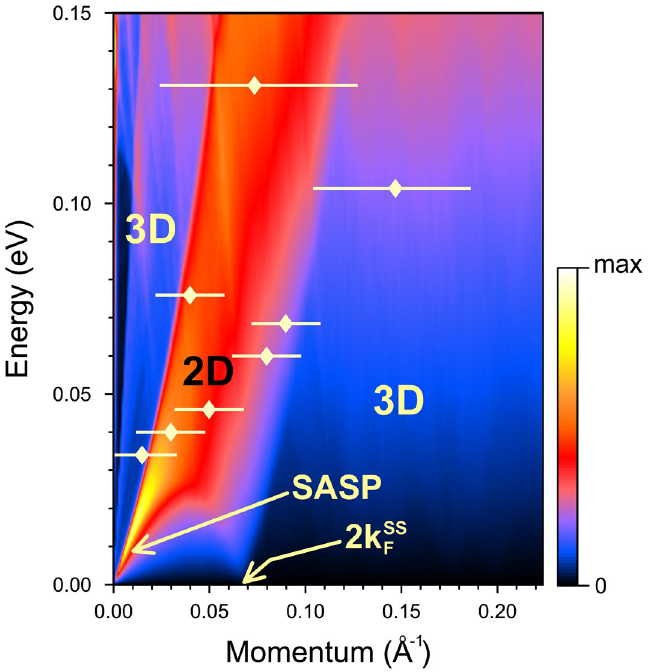
g ( Q , ω) Figure 6. Calculated surface loss function, Im , of the Ni(111) surface divided by Q . Region in the Q - ω [ ] plane dominated by single-particle intraband excitations in the majority-spin surface state is labeled as 2D. The regions where the electronic excitations within the bulk electronic system are available only are marked as 3D. A peak marked as SASP corresponds to the spin acoustic surface plasmon. The experimental data are shown by diamonds with horizontal lines representing the experimental